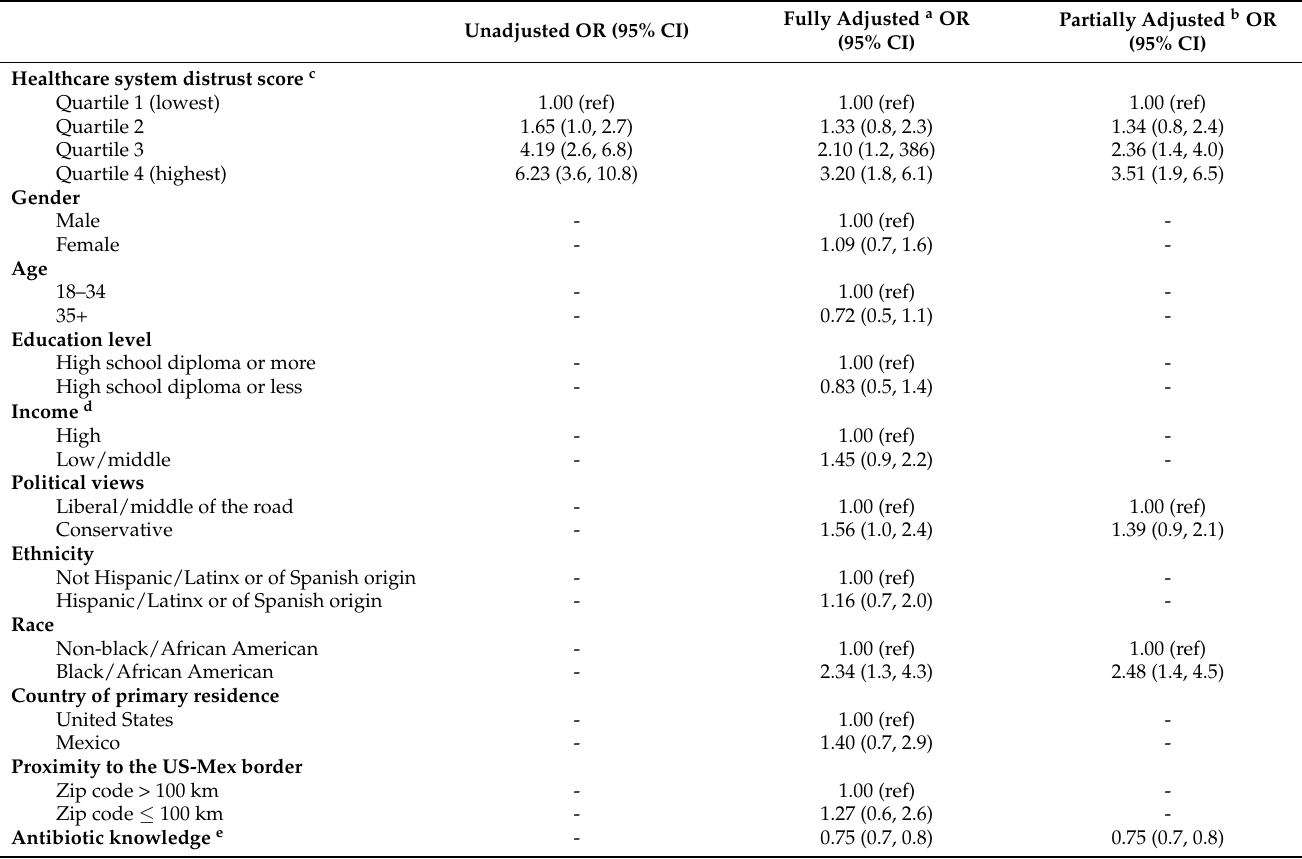
Table 2. Results of logistic regression analysis for non-prescription antibiotic use with healthcare system distrust as a predictor (n = 568). Unadjusted OR (95% CI)